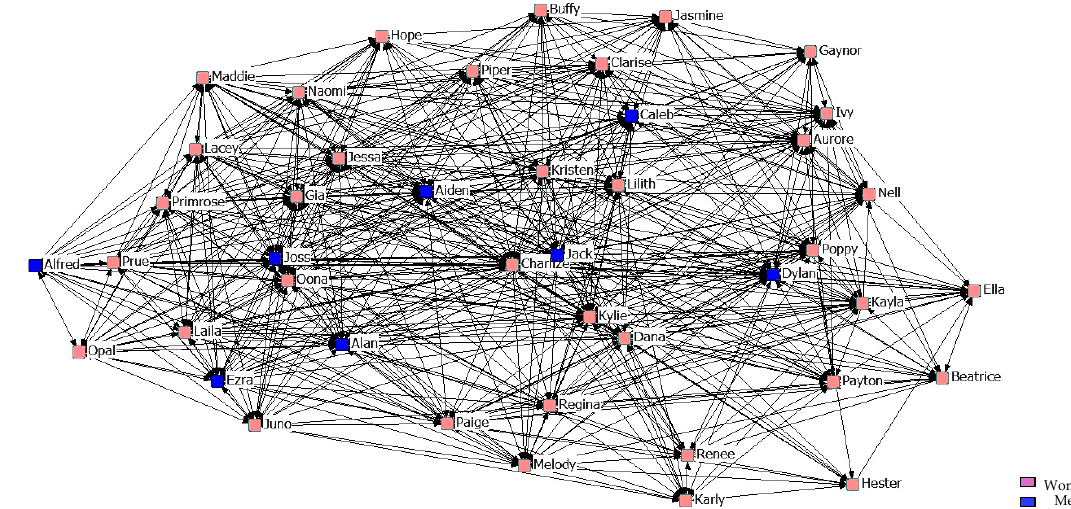
Figure 7. Graph of the second year Minimum Friendship Network.